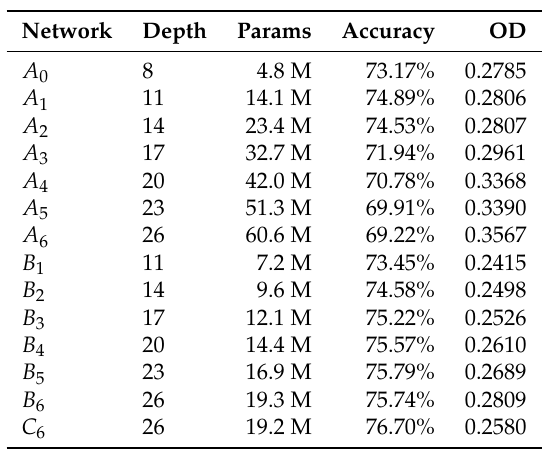
Table 3. Performance comparison based on 5 fold cross-validation. A 0 ∼ A 6 are normal 3D CNNs